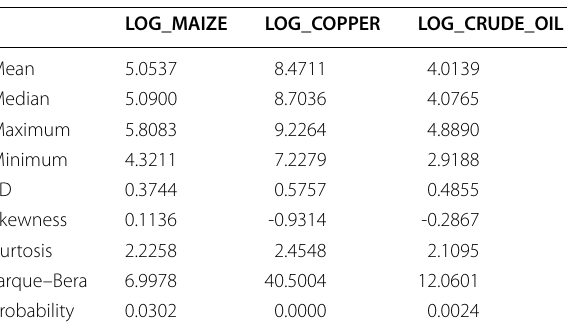
Fig. 1 Maize, copper and crude oil price trends 1982—2021